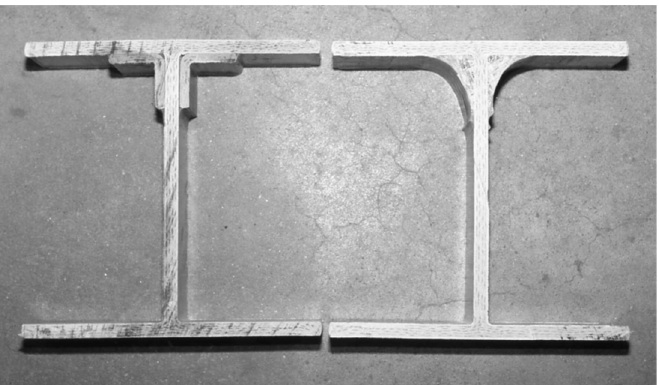
Figure 17. Corners of I-shape PFRP beam (203 mm × 203 mm × 9.5 mm, radius 2.38 mm) enhanced by (left side) polyester pultruded equal leg angles (38 mm × 38 mm × 6.4 mm) and (right side) hand-layup fillets (38 mm) on the top corners [61].